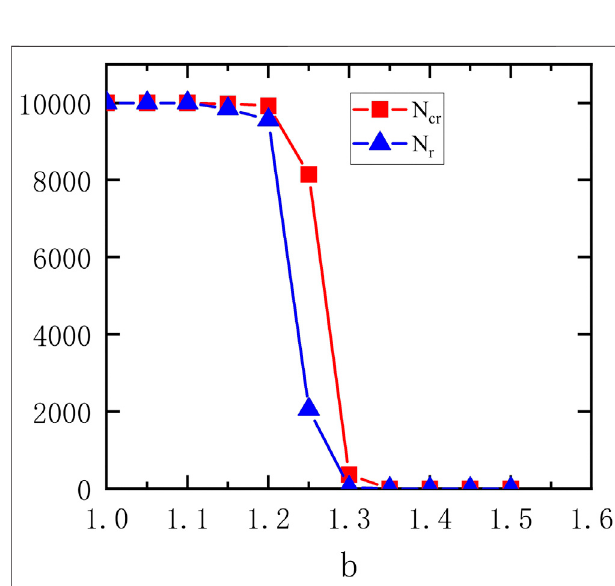
FIGURE 5 | The size of the largest cluster of all kinds of cooperators (including cooperators and cooperative rewarders) S cr and the cooperators who isn ’ t a rewarder S c at the last MC step evolves respectively when cost (cid:1) 0.1 and reward (cid:1) 0.3.